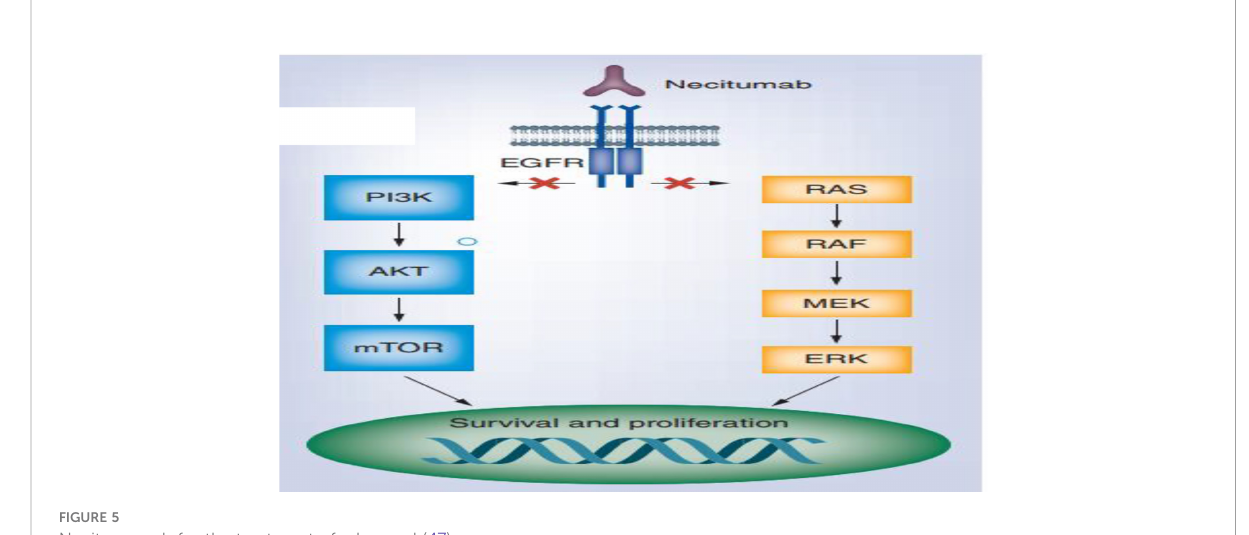
FIGURE 5 Necitumumab for the treatment of advanced